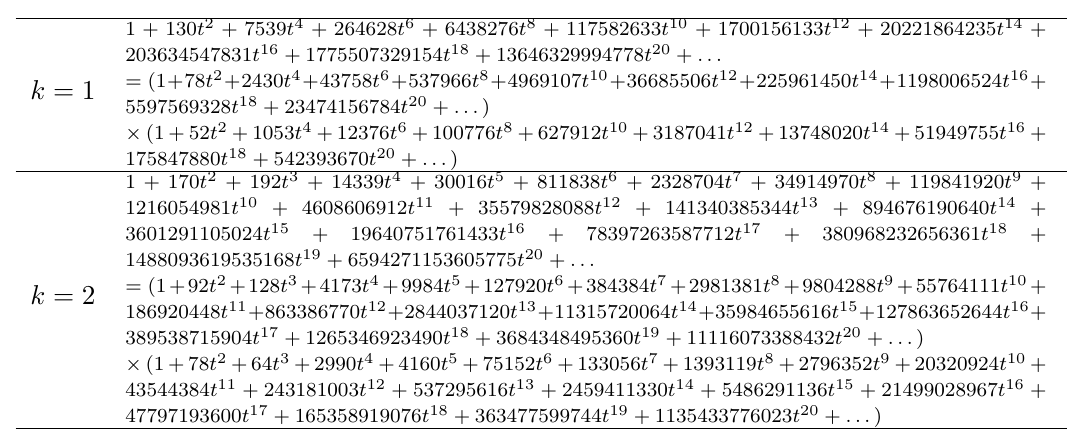
Table 16. Hilbert series results for (3.9). The first line displays the Coulomb branch Hilbert series for (3.9), while the second line displays the factorisation into a product. Each factor agrees with the known Hilbert